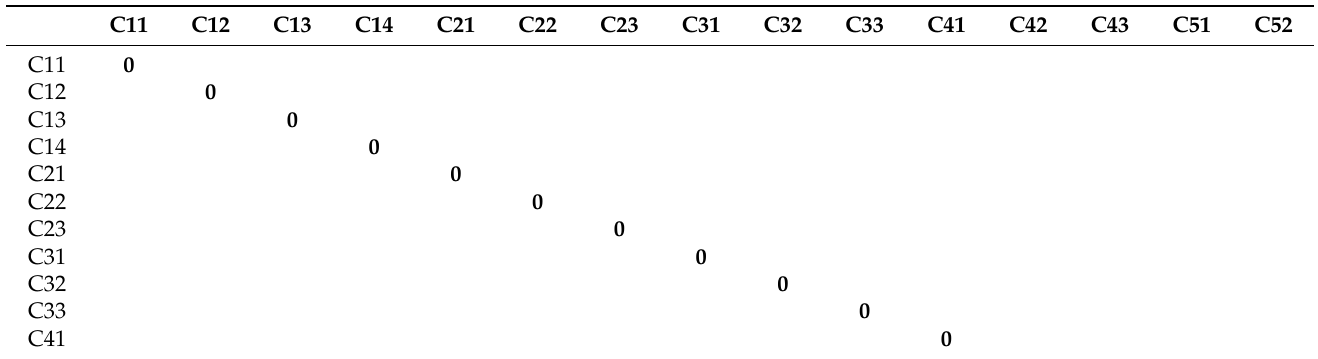
Figure A1. Our case, which is a map of Tehran, Iran. Table A1. Questionnaire sample in the present research (there is no relation between bold items).